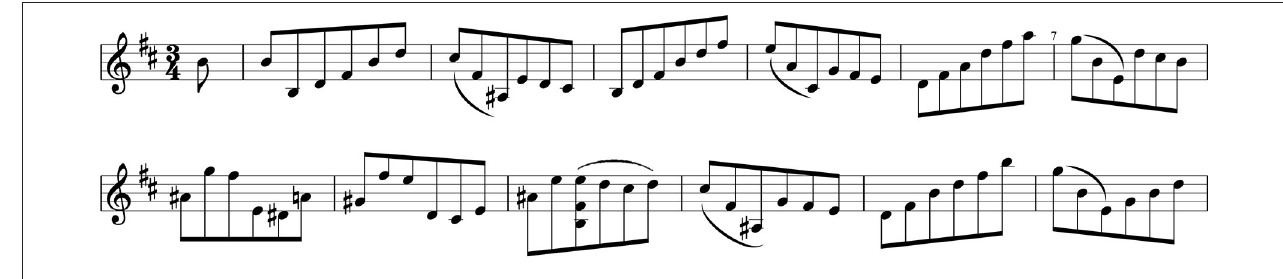
FIGURE 3 | The first two staves of the Bach Courante from BWV 1002 that all performers played in each